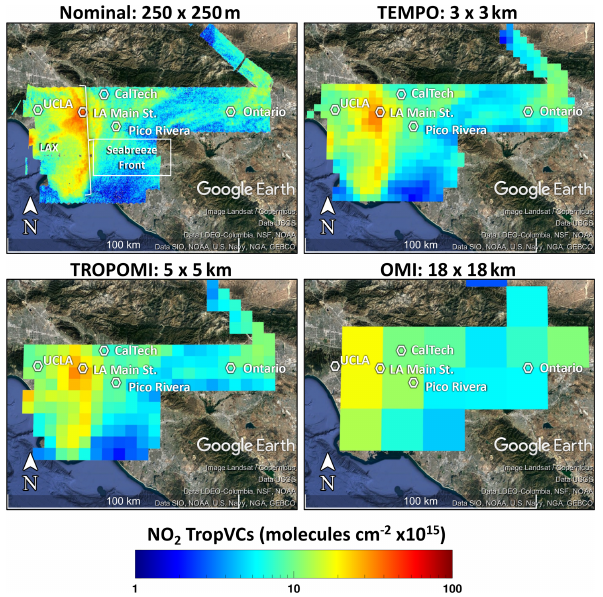
Figure 7. Maps of GeoTASO NO 2 TropVC on a log 10 color scale averaged to the labeled pixel sizes to demonstrate the spatial de- tail that would be observed from the midday raster in Los Angeles on 27 June 2017. All pixels shown have at least 30% of their area mapped by GeoTASO during this timeframe. Base map created in ©Google Earth Pro.